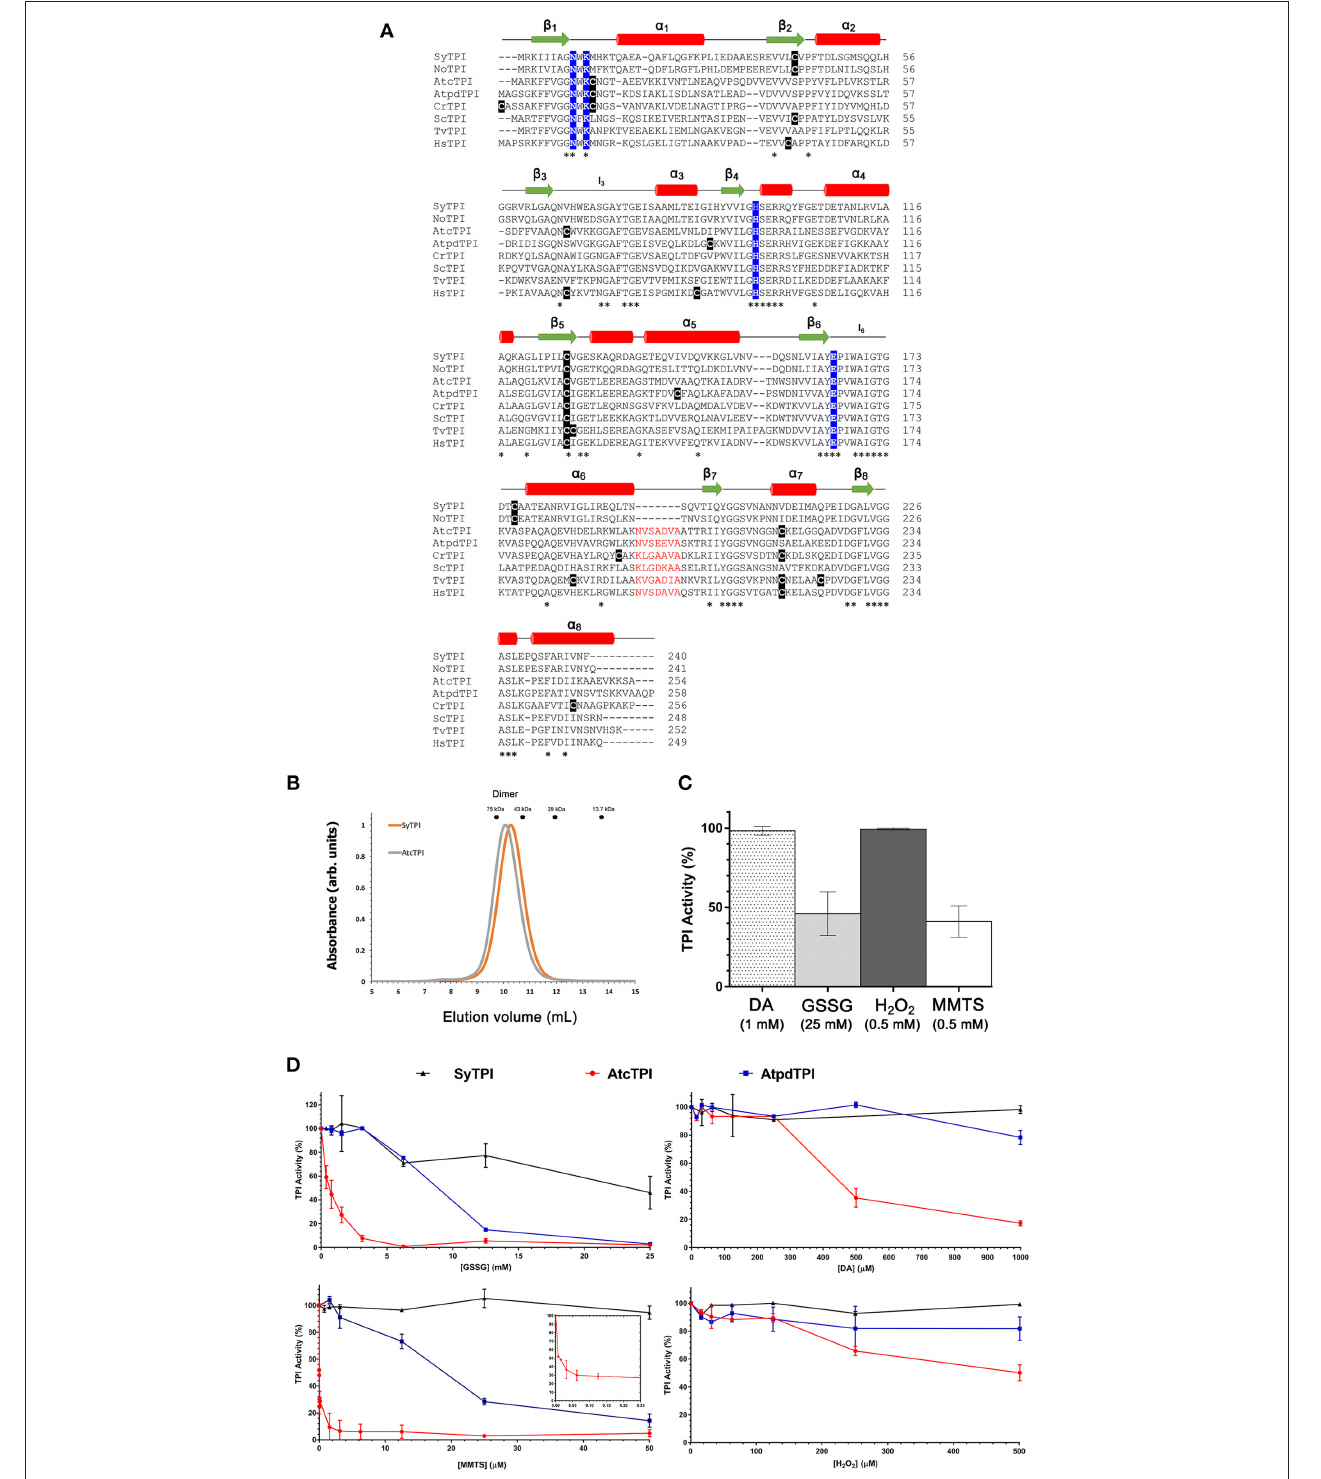
FIGURE 1 | (A) Multiple sequence alignment and secondary structure elements of TPIs from diverse organisms: SyTPI ( Synechocystis sp. PCC 6803), NoTPI, ( Nostoc sp. PCC 7107), AtcTPI, ( Arabidopsis thaliana cytosolic TPI), AtpdTPI ( Arabidopsis thaliana chloroplastic TPI), CrTPI ( Chlamydomonas reinhardtii ), ScTPI ( Saccharomyces cerevisiae ), TvTPI ( Trichomonas vaginalis ), and HsTPI ( Homo sapiens ). Conserved residues are marked with an asterisk (*). The cysteine residues are highlighted in black, catalytic residues (Asn 9, Lys 11, His96 and Glu 167) are highlighted in blue. A deletion of seven amino acids present in TPIs from Synechocystis